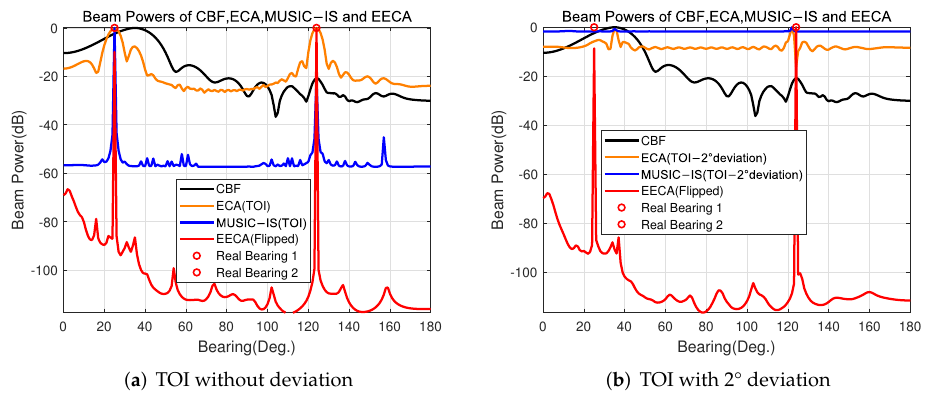
Figure 3. Comparison of beam power spectra among the CBF, ECA, MUSIC-IS, and EECA in Scenario I.